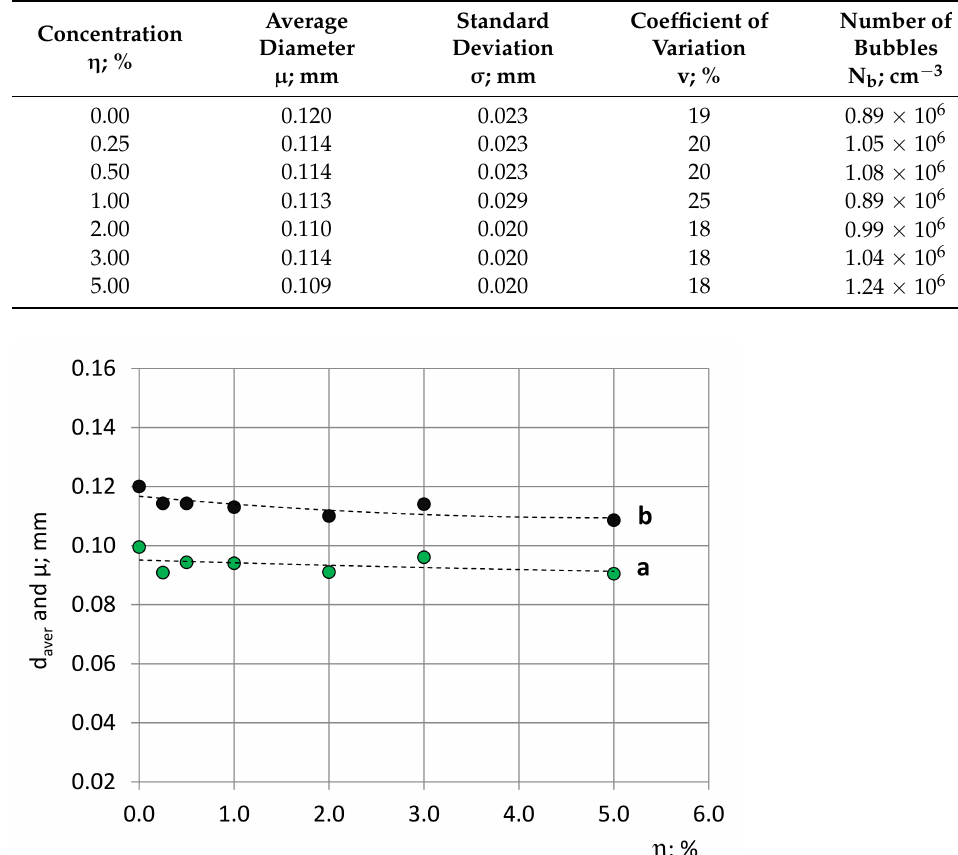
Table 6. Distribution characteristics of the bubbles’ diameters.